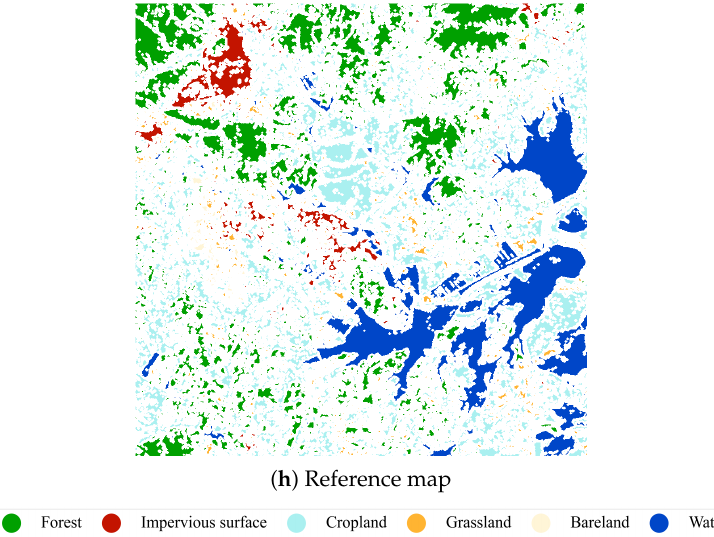
Figure 9. Clustering maps of Poyang Lake dataset generated by different similarity measures and the reference map of Poyang Lake dataset. The unclassified pixels (white color) are caused by morphological erosion operations to improve reliability. When evaluating performance, we only use classified pixels shown in this reference map. ( a ) Euclidean distance;